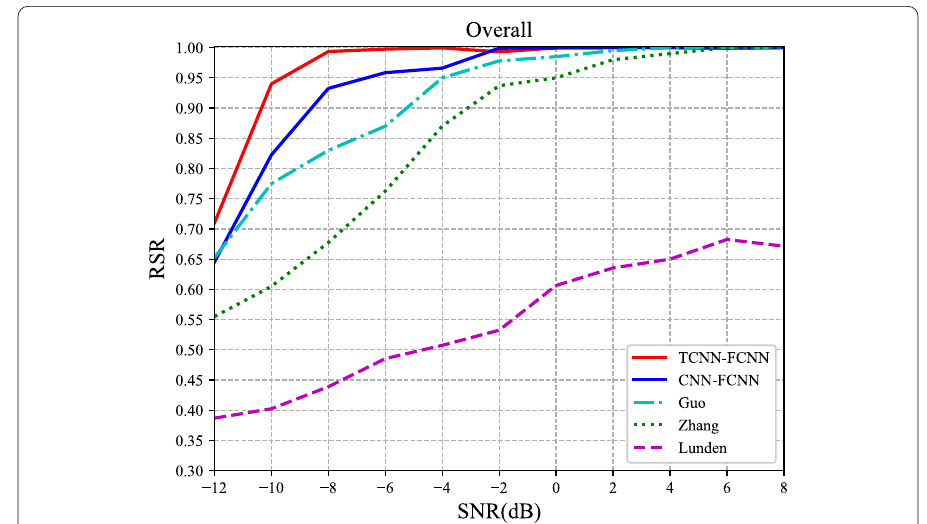
Fig. 8 Recognition accuracy of LPI radar signals under different SNR